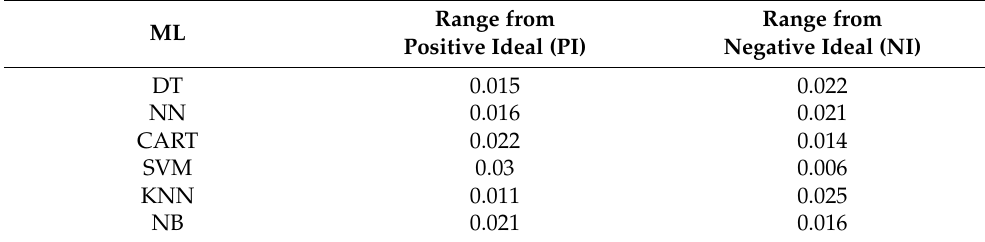
Table 8. Range from positive as well as negative ideal alternative solutions.